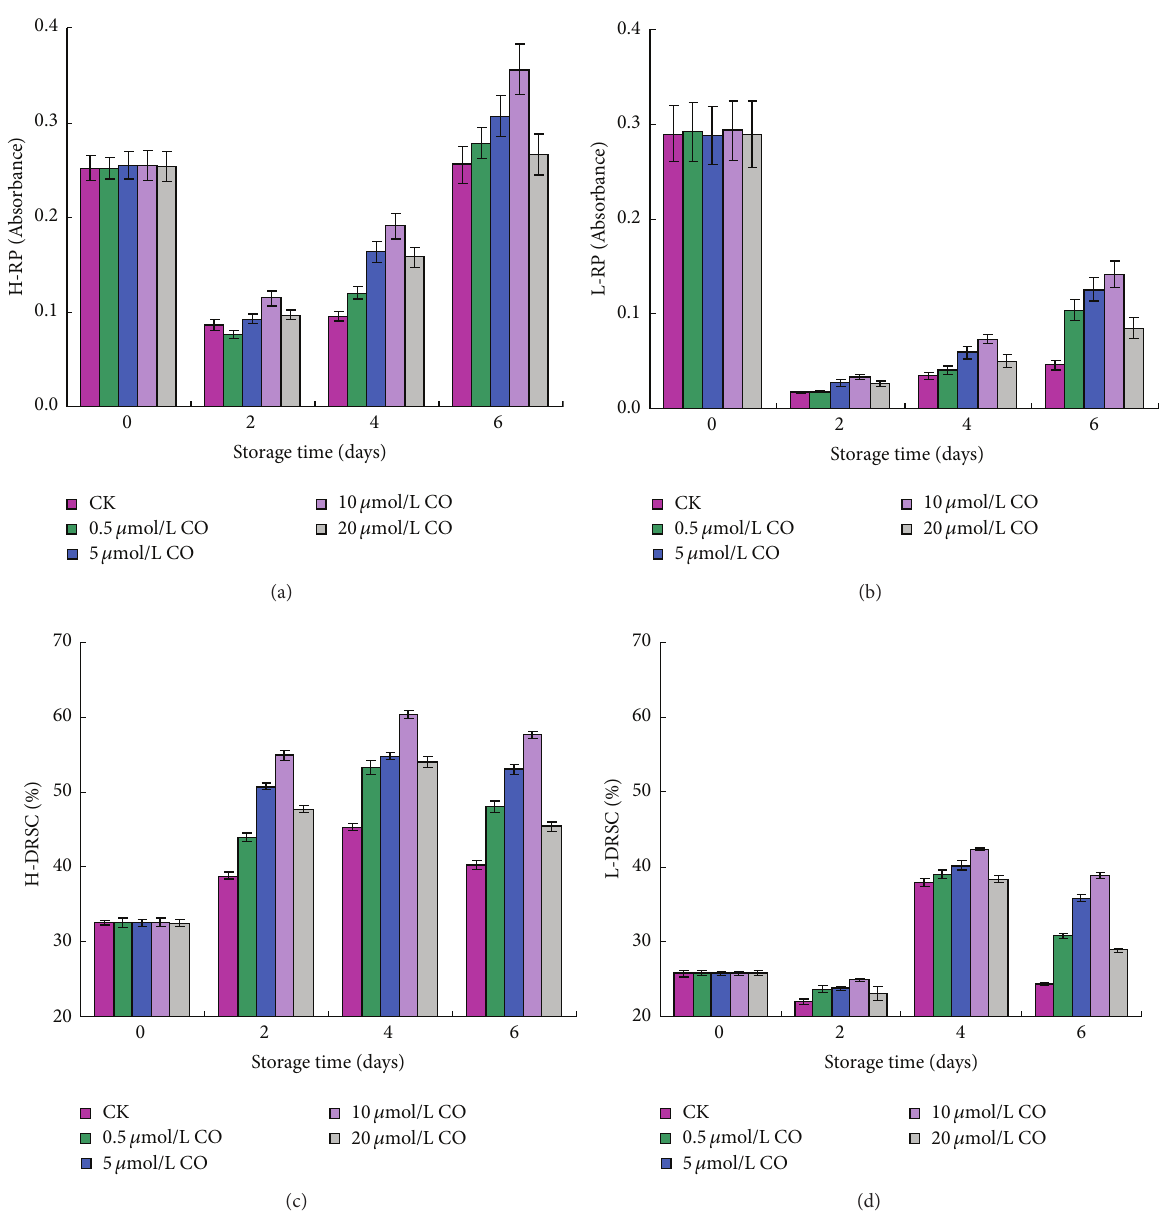
Figure 5: Effect of CO fumigation on H-RP (a), L-RP (b), H-DRSC (c), and L-DRSC (d) of postharvest peaches. Each point represents the mean value ± SD. H-RP stands for hydrophilic compounds reducing power, and L-RP stands for lipophilic compounds reducing power. H- DRSC represents the DPPH radical scavenging capacity of hydrophilic compounds, and L-DRSC represents the DPPH radical scavenging capacity of lipophilic